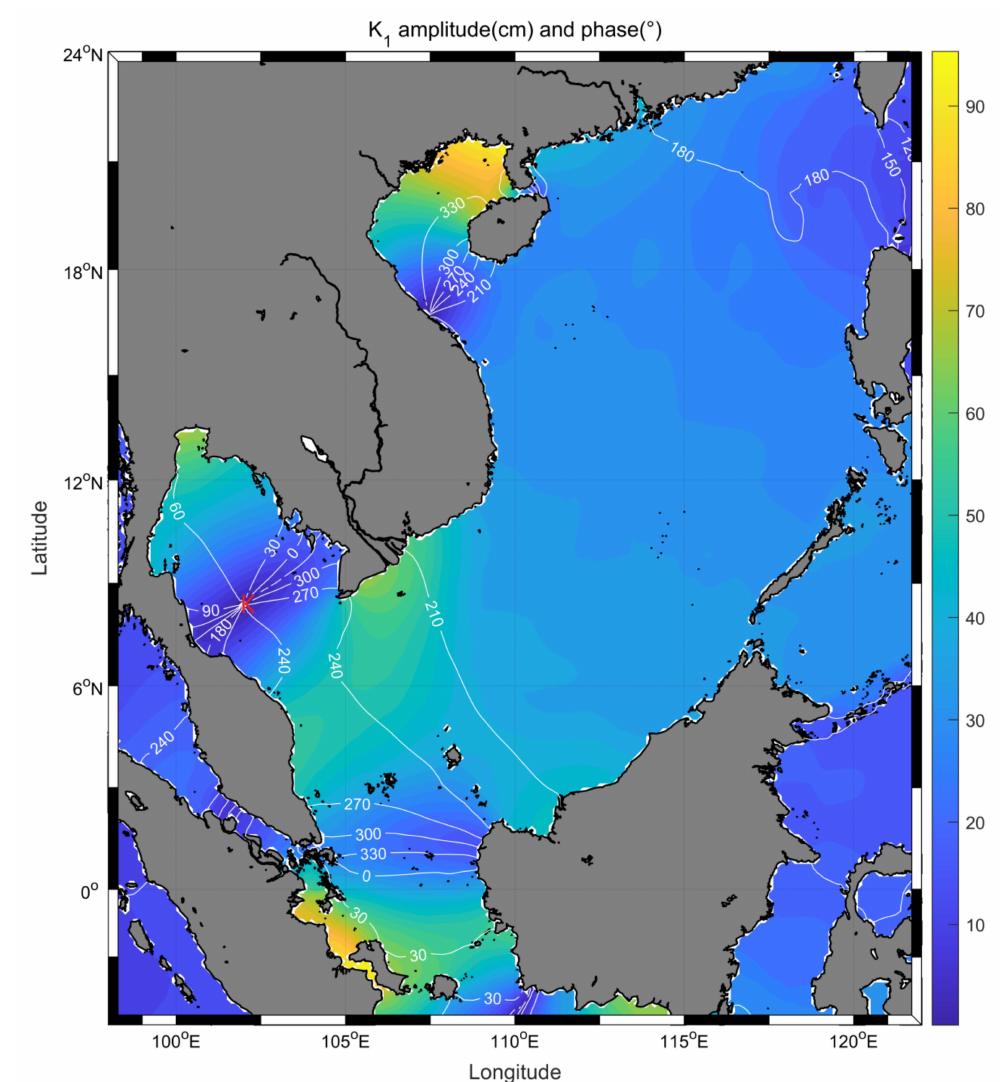
Figure 4. Same as Figure 2, but for the South China